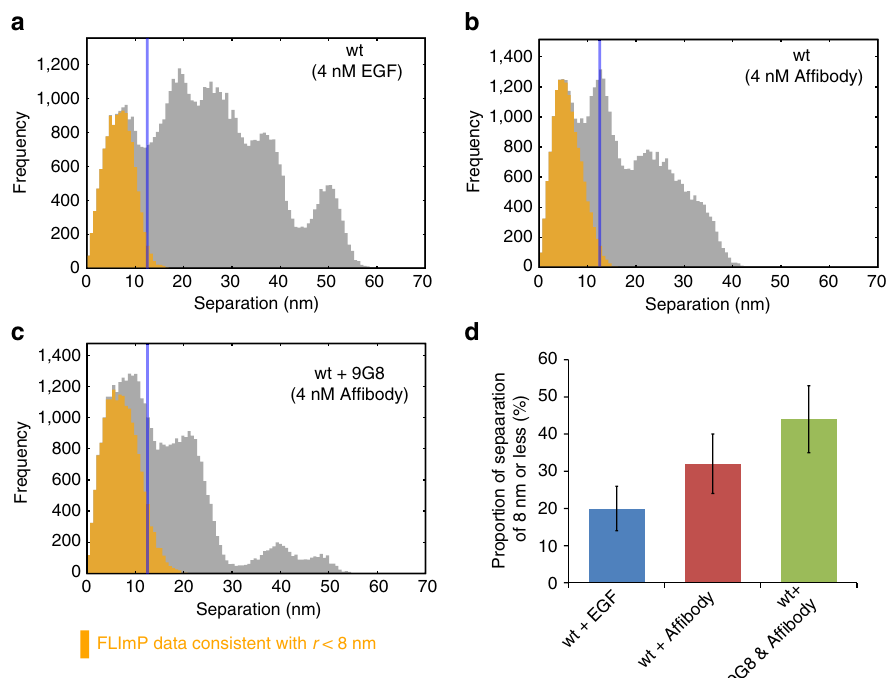
Figure 7 | The tethered ectodomain signature in FLImP distributions. ( a ) FLImP distribution (grey) of pairwise separations of fluorophore-conjugated EGF bound to EGFR on CHO cells treated with 4nM EGF (identical data as shown in Fig. 3d) and the distribution (yellow) compiled from all FLImP measurements whose 69% confidence interval overlaps with the range of 0–8nm for the inactive dimers. ( b ) Similar to a , FLImP distribution of cells treated with 4nM anti-EGFR Affibody. ( c ) Similar to b on cells pre-treated with 200nM 9G8 nanobody and 4nM Affibody. The distributions in b , c contain data from 37 and 33 FLImP measurements, respectively. The expected range of separations for dimers is indicated by the vertical blue lines. ( d ) Estimate of the relative population of the inactive dimers as indicated by ratio of the yellow integral area to the corresponding total grey integral area. Errors are calculated as described in Fig.